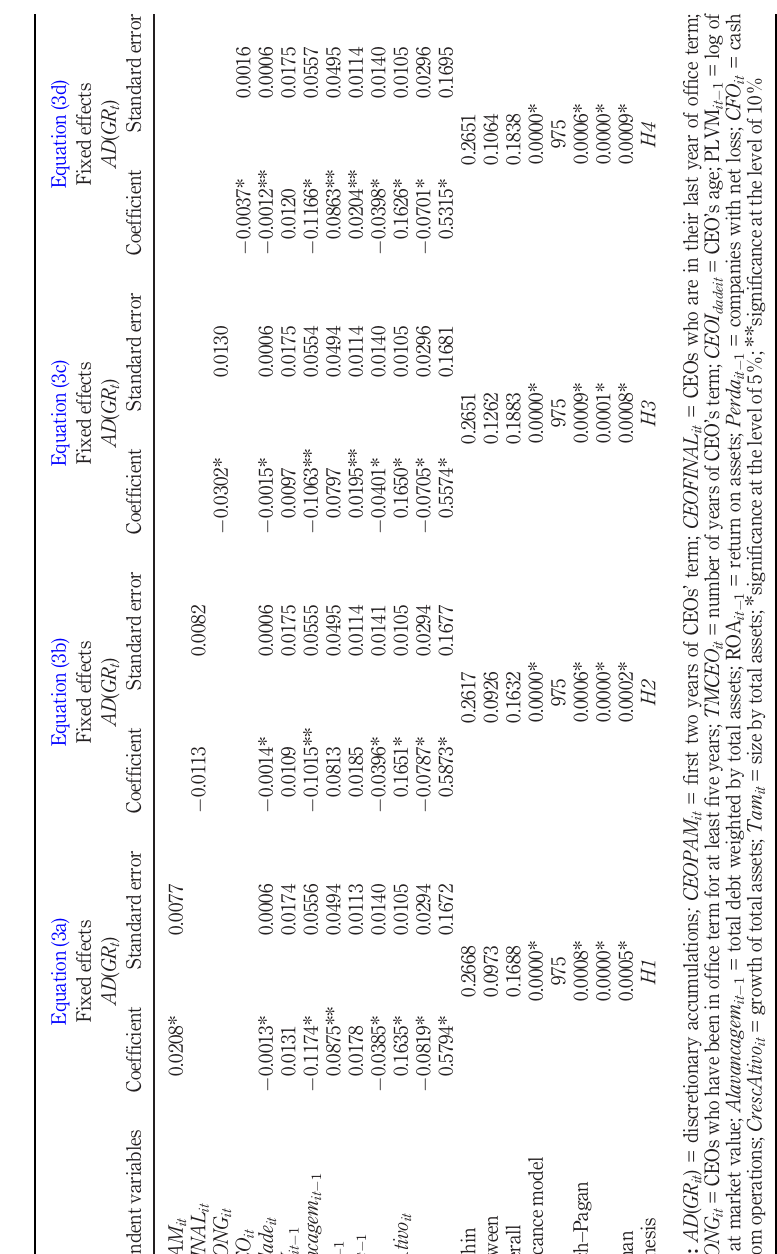
Table II. Relationship between the assumptions of CEOs ’ term time length and the use of discretionary